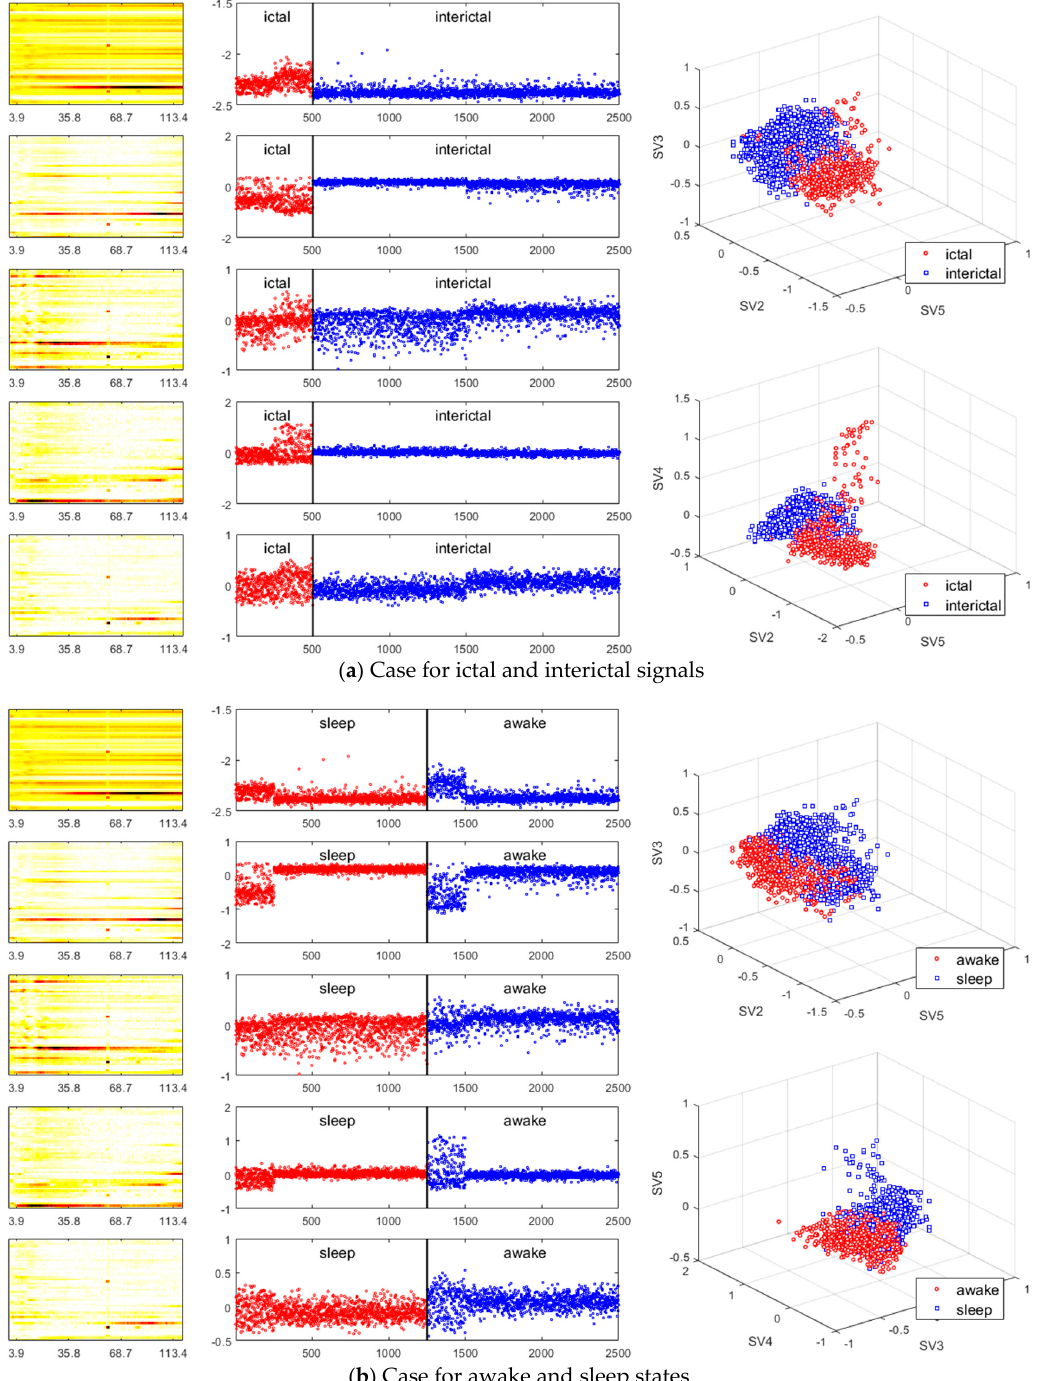
Figure 6. Patterns of left singular vector space and distribution of feature, which refer to the columns of U d and a L in Equation (19), respectively. The five images in the first column are obtained from reshaping the magnitudes of the first five singular vectors into the form of the DMD mode. Here, the horizontal axis represents frequency and the vertical one channel. In each image in the second column, all the components of features associated with each singular vector are plotted. Here, each red circle represents an ictal signal or awake state as implying positivity, while each blue rectangle represents an interictal signal or sleep state as implying negativity. Here, the horizontal axis represents the index of the signal, and the vertical one weight. The images in the third column represent the distribution of features in three-dimensional space according to the components of the singular vector.